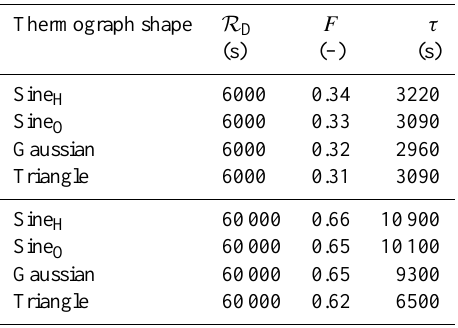
Table 4. Thermal transmission factors and retardation values of open channel simulations with different A d / A w ratios.